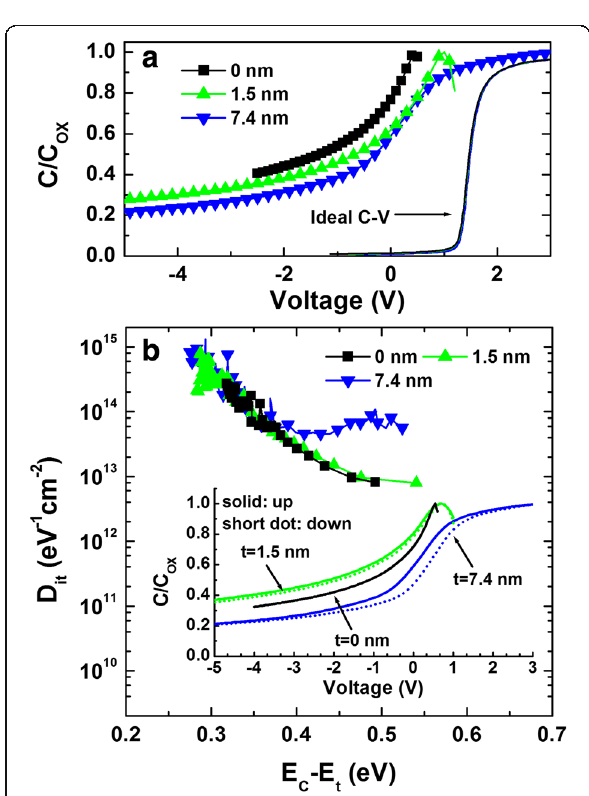
Fig. 5 a Comparison of experimental capacitance – voltage ( C – V ) data measured at 1 MHz and ideal C – V data and b interface state density ( D it ) distributions determined by applying the Terman method for the samples with 0-, 1.5-, and 7.4-nm-thick AlN layer. The inset in b shows the C – V hysteresis plots measured at 1 MHz